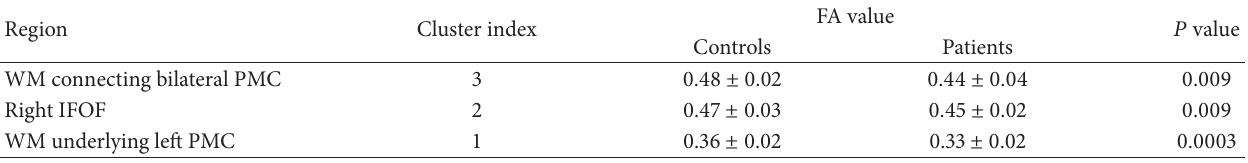
Table 3: The differences of FA values in fiber tracts generated from tractography.